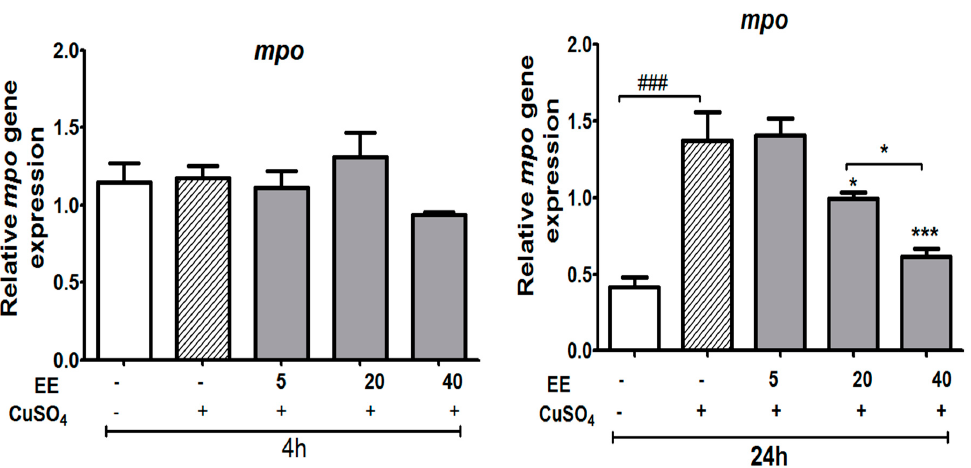
Figure 8. Relative expression of genes involved in immune responses ( mpo ) of zebrafish larvae after exposure to CuSO 4 and treatment with the ethanol extract (EE) of C. cyrtophyllum Turcz. The data are presented as mean ± S.E. for three different experiments performed in triplicate. * p < 0.05, ** and ### p < 0.01, *** p < 0.001 compared to the CuSO 4 alone group.